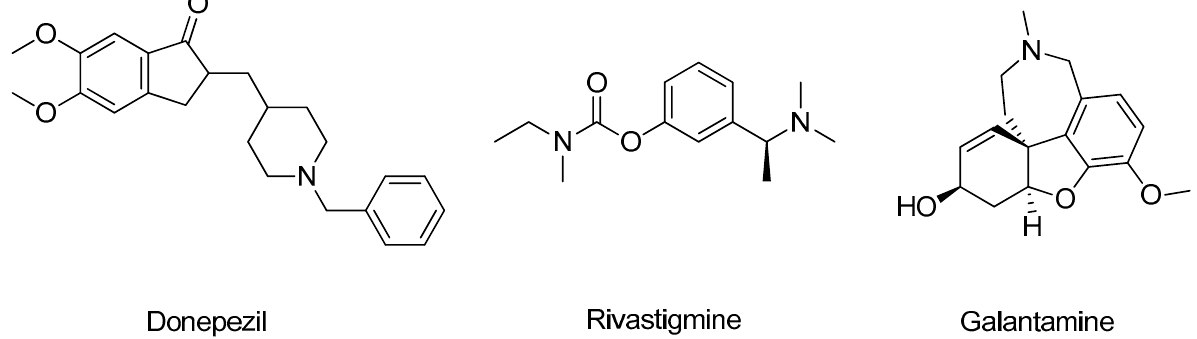
Figure 1. Structure of the clinically approved AChE inhibitors.